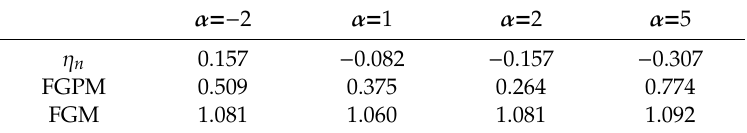
Table 4. Center deflections u z ,max ( × 10 − 7 ) of FGPM plates and functionally-graded material (FGM) plates. α = − 2 α = 1 α = 2 α = 5 η